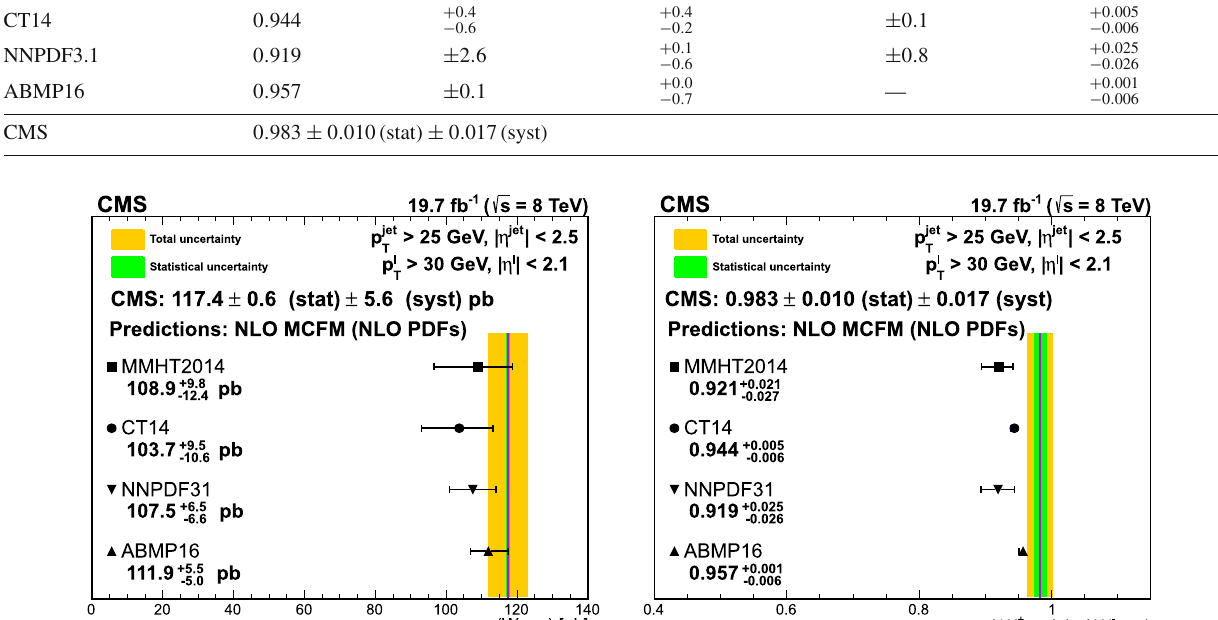
Fig. 4 Comparison of the theoretical predictions for σ( W + c ) (left) and σ( W + + ¯ c )/σ( W − + c ) (right) computed with mcfm and several sets of PDFs with the current experimental